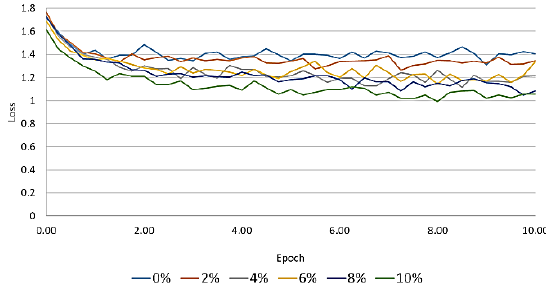
Figure 4. Loss evolution with different percentage of point cloud images in training set and point cloud images in validation set.